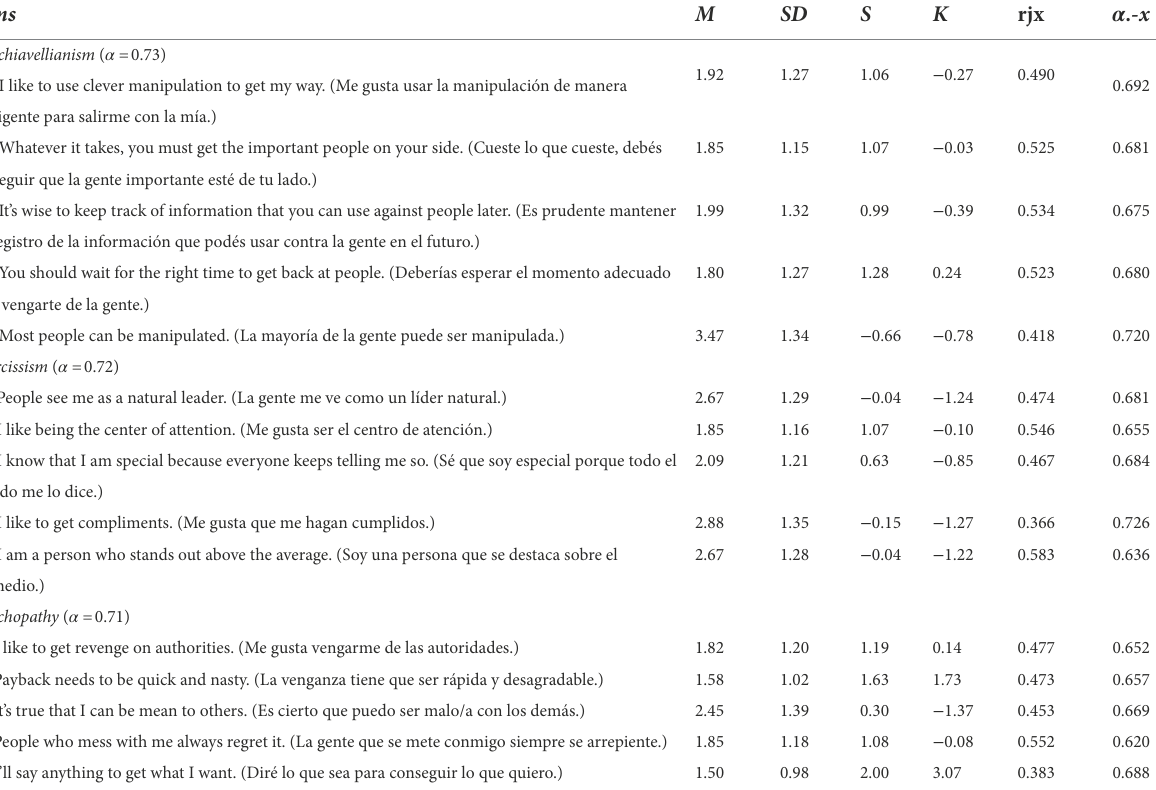
TABLE 2 Descriptive statistics of the items of the Short Scale of the Dark Triad. items M SD S K